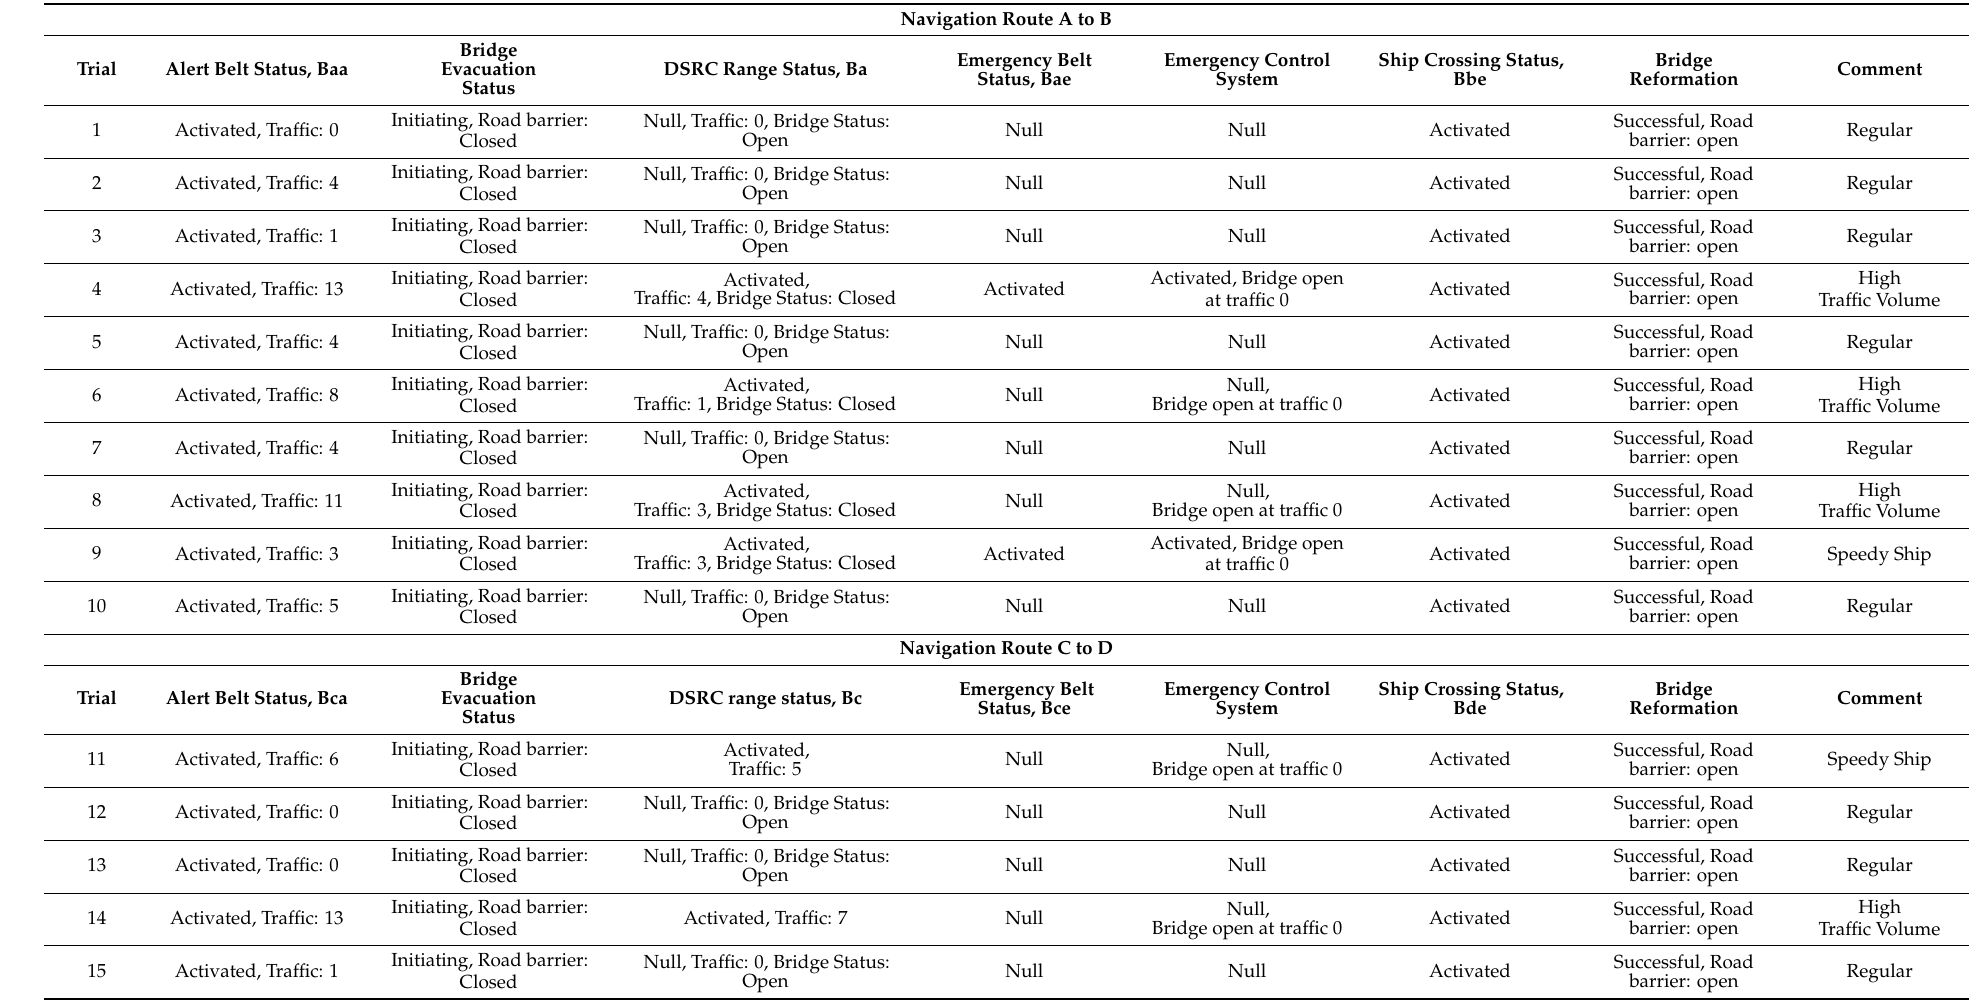
Table 1. Performance result of the simulation for 20